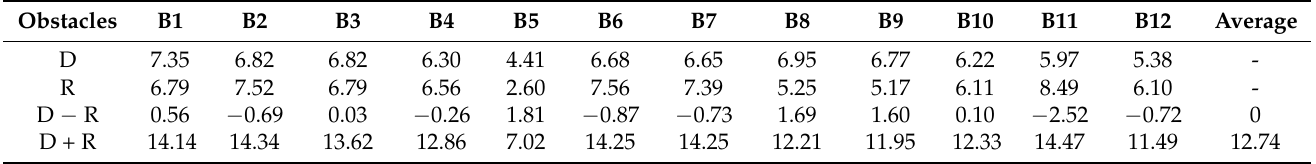
Table 14. Prominence and relation results obtained by using the DEMATEL